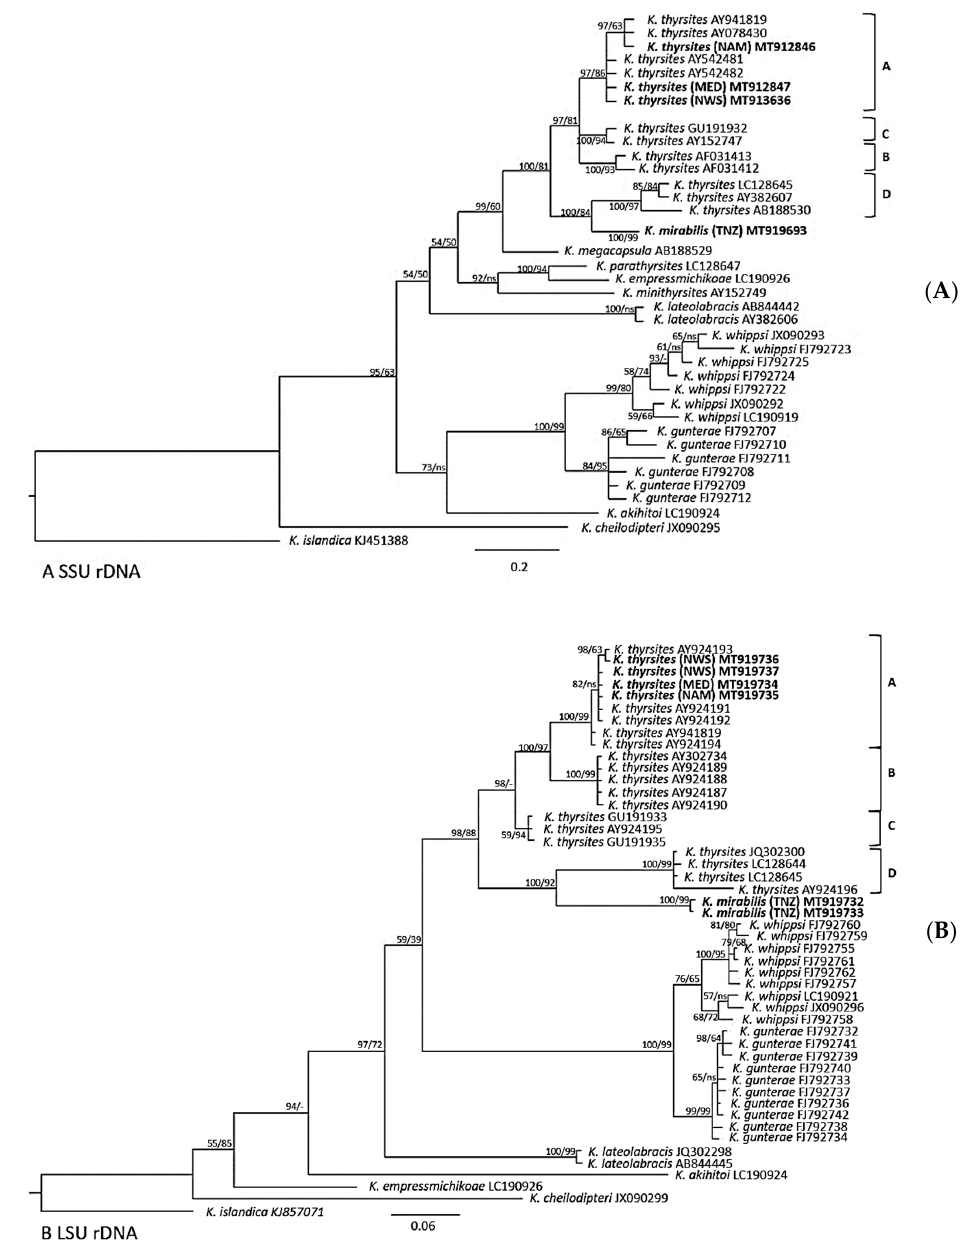
Figure 4. Bayesian inference (BI) phylogenetic tree based on sequences of ( A ) SSU rDNA dataset and ( B ) LSU rDNA dataset. Species from this study are shown in bold. Locality of each new isolates obtained from this study are listed to the right with the following abbreviations: TNZ, ( Kudoa mirabilis ex T. lepturus from Tanzanian waters); NAM, ( Kudoa thyrsites ex T. atun from Namibian waters); MED, ( K. thyrsites ex L. caudatus from Mediterranean Sea); and NWS, ( K. thyrsites ex Scomber scombrus from Norwegian Sea). GenBank accession number follows each taxon. Kudoa islandica was set as outgroup. Nodal supports are indicated for BI (posterior probabilities) and ML (bootstrap, n = 1000); Nodal values with < 50 support are indicated by dashes (-); (ns) denotes a different branching for the ML tree. There are two K. thyrsites clade identified robustly supported: the major clade, including isolates from Atlantic Ocean, Pacific Ocean, Australia (labelled subclades A–C), and a small subclade, including isolates from Japan and one single isolate from South Africa (in LSU tree) (labelled subclade D). The latter clade formed as a sister lineage to K. mirabilis.